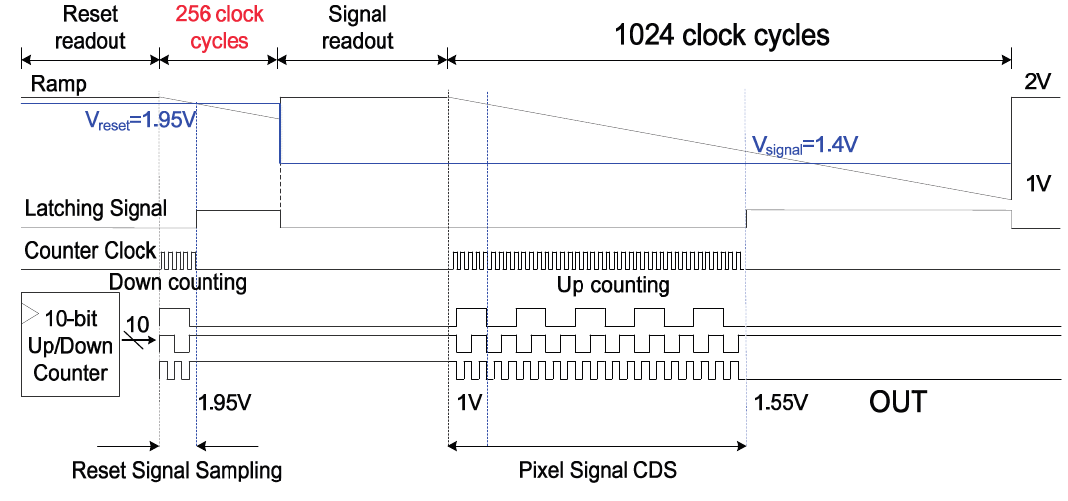
Figure 1. A CMOS image sensor with a single-slope ADC (SS-ADC): ( a ) block diagram of a CIS; ( b ) circuit diagram of a single-slope ADC with an analog CDS.